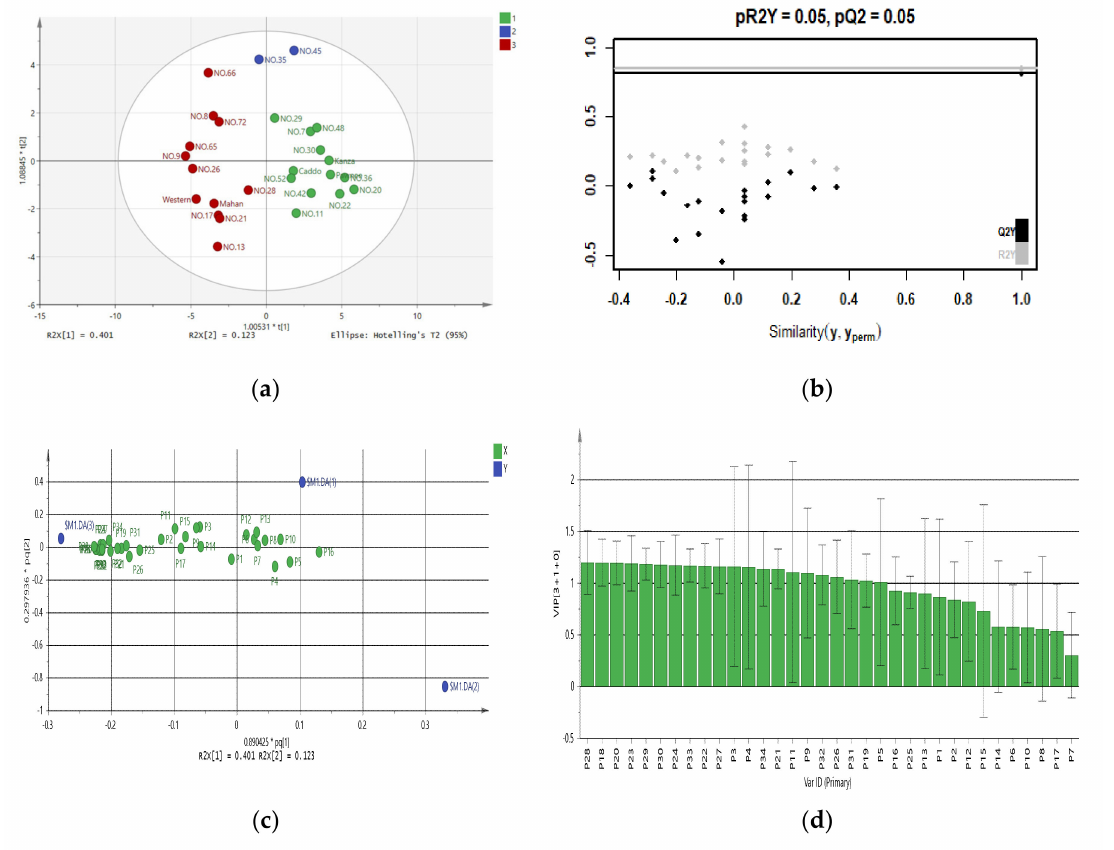
Figure 3. Score chart of OPLS-DA ( a ), significance diagnostic diagram ( b ), loading diagram ( c ), and VIP value ( d ) in the pecan OPLS-DA score chart of the fruit quality components of pecans. The picture is generated by SIMCA software, “R2x[1]”, “R2x[2]” is the interpretation rate corresponding to principal components 1 and